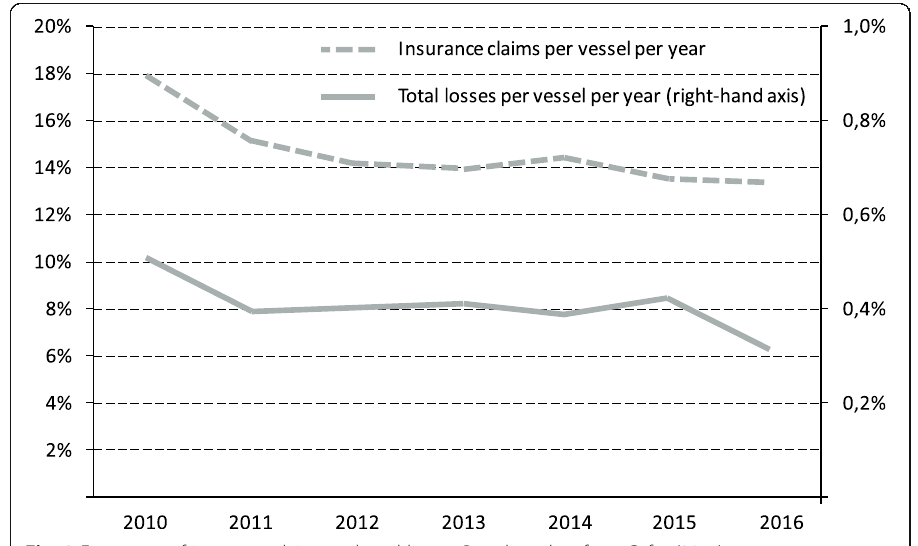
Fig. 2 Frequency of insurance claims and total losses. Based on data from Cefor